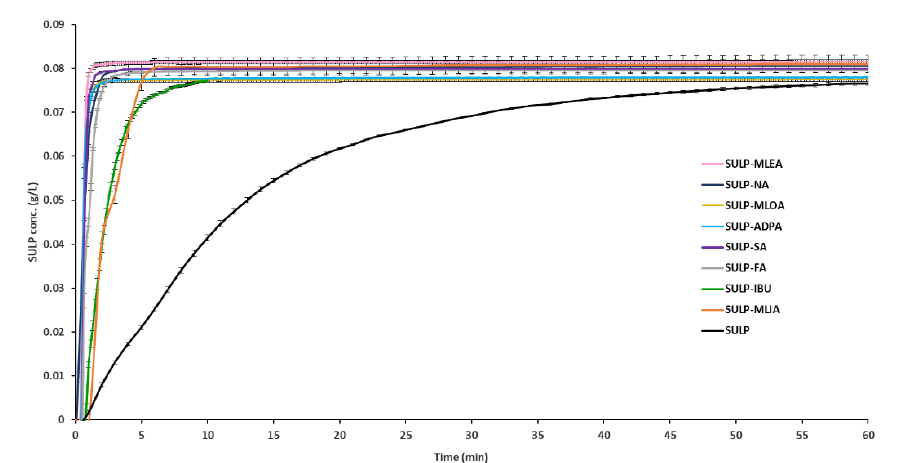
Figure 9. Dissolution profiles of pure SULP (black) and adducts: SULP-ADPA (light blue), SULP- FA (grey), SULP-MLEA (pink), SULP-MLIA (orange), SULP-MLOA (yellow), SULP-NA (blue), SULP-SA (purple), SULP-IBU (green).